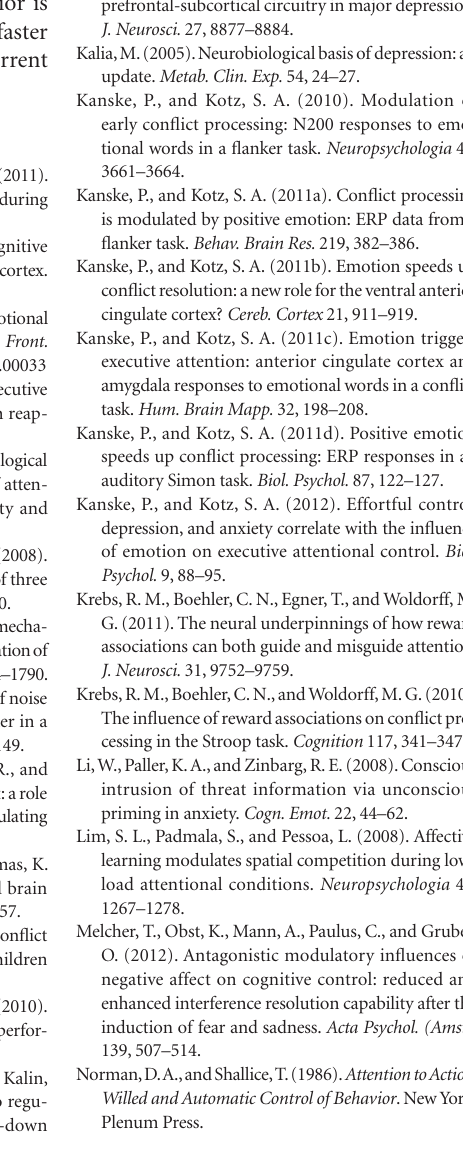
FIgure 1 | Illustration of the functional integration of emotion and cognitive control in conflict processing. The situation for neutral (A) and emotional task-irrelevant (B) or task-relevant stimuli (C) is displayed. Circles